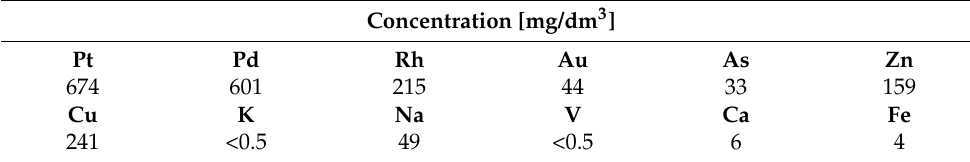
Table 3. Composition of the technological solution obtained by the quantitative